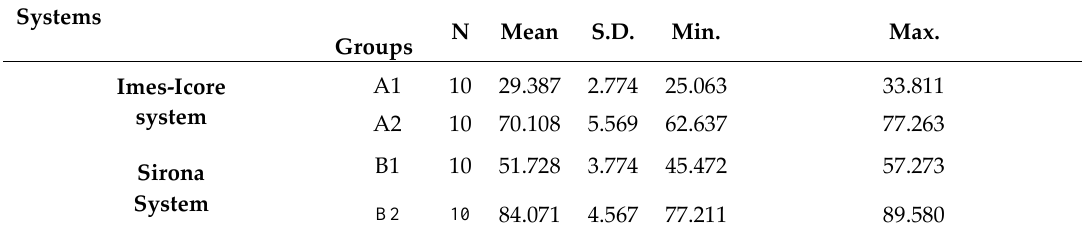
Table 2: Descriptive statistics and effect of crystallization on the marginal gap